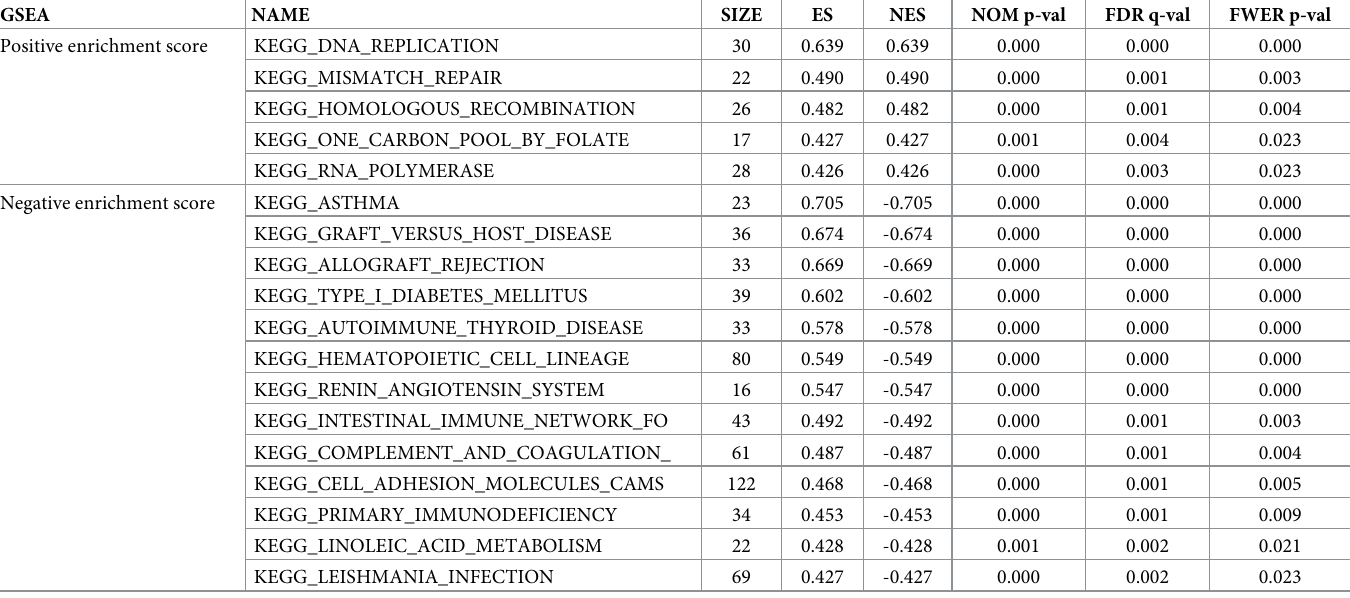
Table 2. Enrichment results for gene